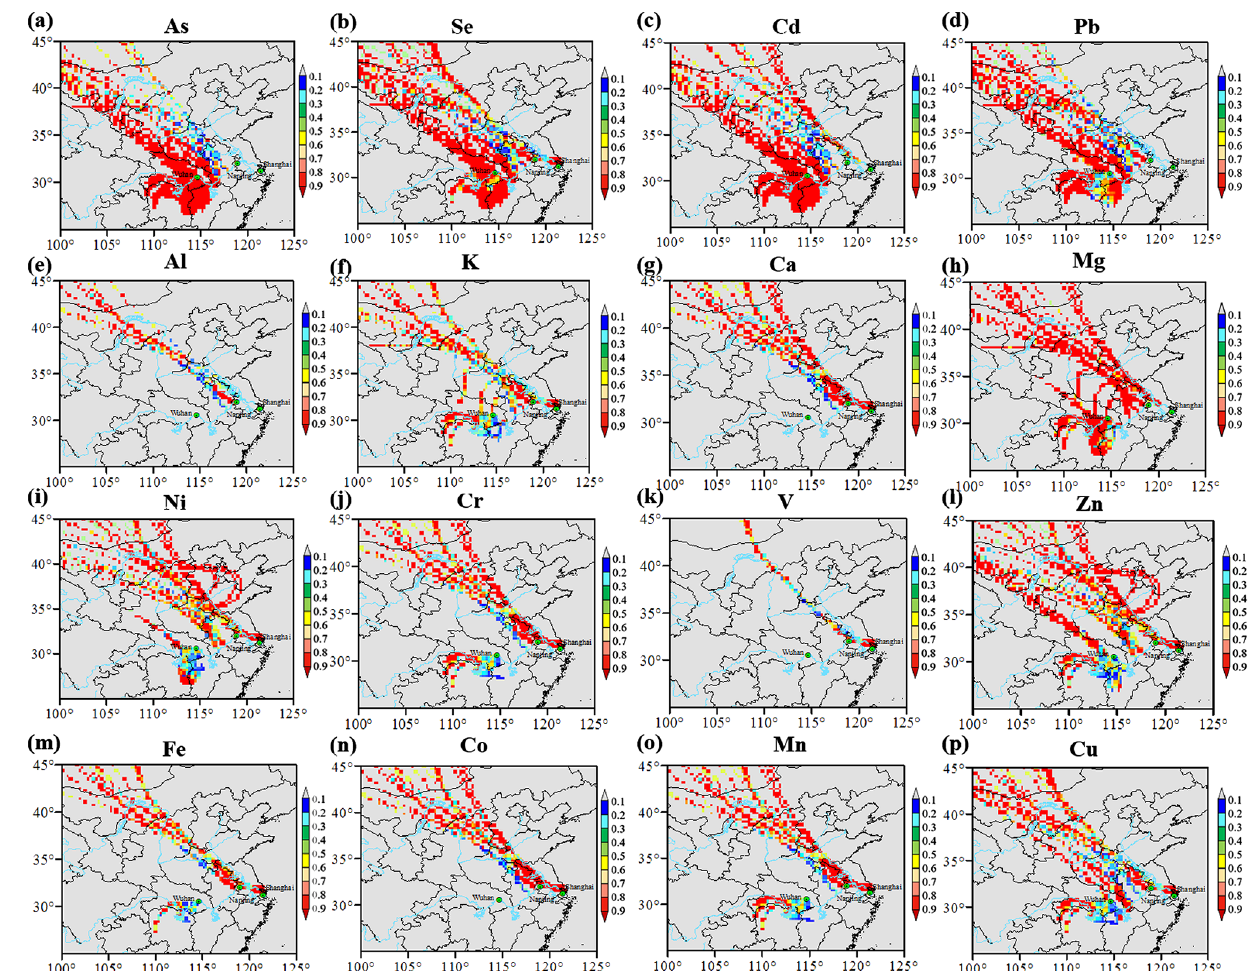
Figure 6. Probable sources from PSCF for individual elements in PM 2 . 5 during the YRC. The criteria are the mean concentration for